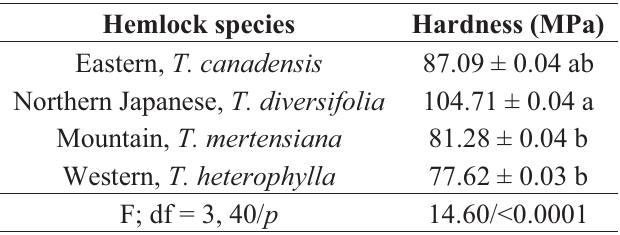
Table 2. Species-specific hardness (mean ± s.e.) (MPa) of four Tsuga species at the feeding stylet insertion point of the hemlock woolly adelgid, Adelges tsugae . Means separation performed on log-transformed data; means followed by the same letter do not differ ( p < 0.05).